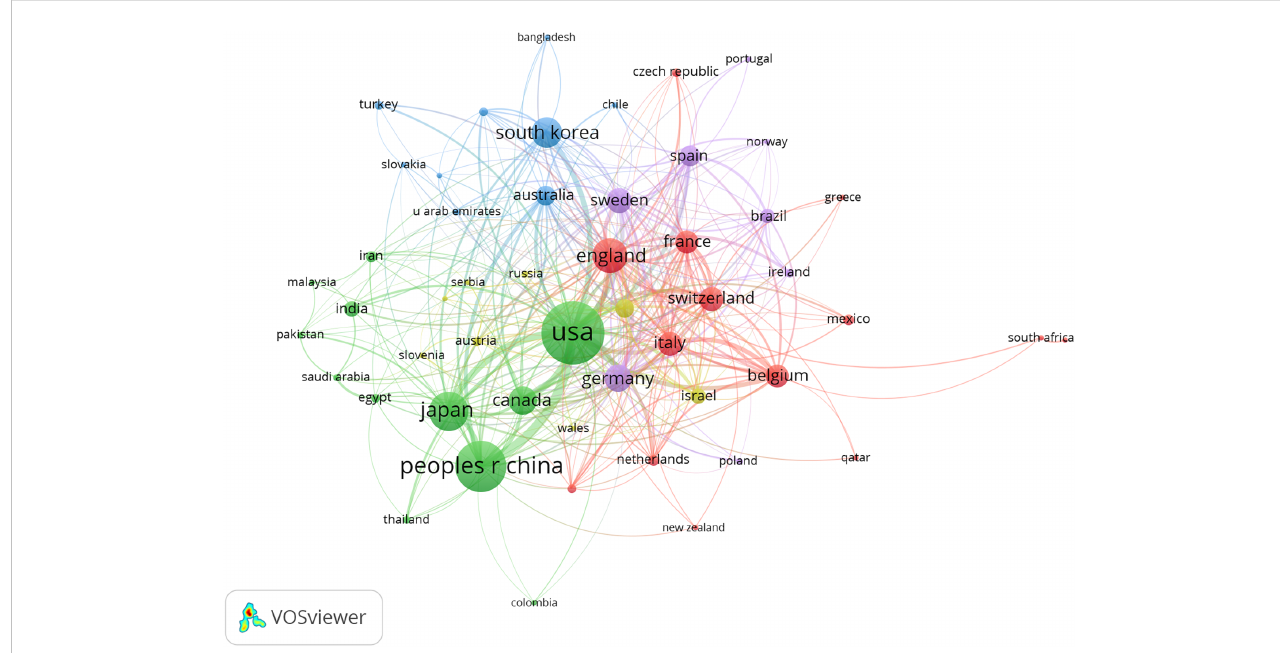
FIGURE 3 The co-occurrence map of countries/regions in beta-cell research. The total link strength was 1307; the layout parameters: Attraction: 2, Repulsion: -1. The circle size means the number of publications; the thickness of the line means the strength of the connection.